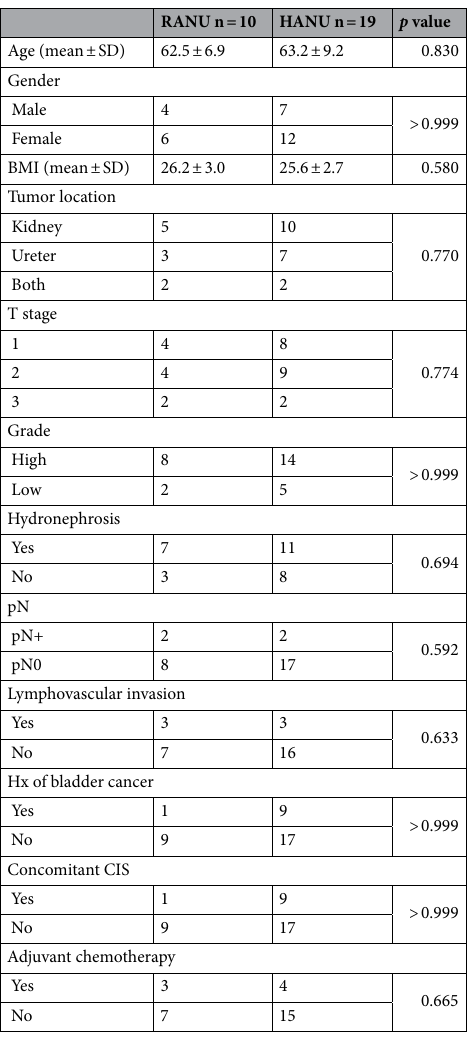
Table 1. Characteristics of UTUC Patients. *p < 0.05 indicates statistical significance.